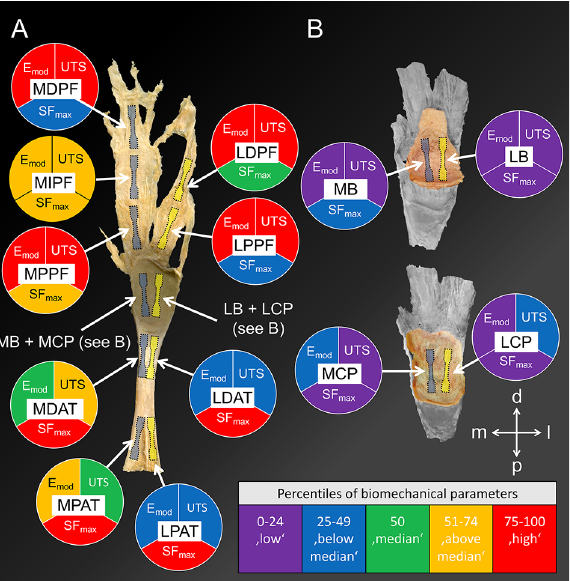
Figure 3. A graphical overview of the obtained biomechanical parameters and the retrieval site of the ‘dog bone’ samples from the Achilles tendon-calcaneus-plantar fascia complex is depicted. The colour code reflects the respective fraction of percentiles that the individual sample belongs to in comparison to all the other samples. ( A ) Samples of the decalcified human Achilles tendon-calcaneus-plantar fascia complex were retrieved according to a medial (blueish ‘dog bones’) and lateral (yellow ‘dog bones’) line, view from inside. MPAT, medial proximal Achilles tendon; MDAT, medial distal Achilles tendon; MPPF, medial proximal plantar fascia; MIPF, medial intermediate plantar fascia and MDPF, medial distal plantar fascia. The following samples were retrieved from the lateral line from proximal to distal: LPAT, lateral proximal Achilles tendon; LDAT, lateral distal Achilles tendon; LPPF, lateral proximal plantar fascia and LDPF, lateral distal plantar fascia. ( B ) A medial bone (MB) and medial calcaneal periosteum (MCP) sample were retrieved. Equally, a lateral bone (LB) and lateral calcaneal periosteum (LCP) sample were retrieved. d, distal; E mod , elastic modulus; l, lateral; m, medial; p, posterior; SF max , strain at maximum force; UTS, ultimate tensile